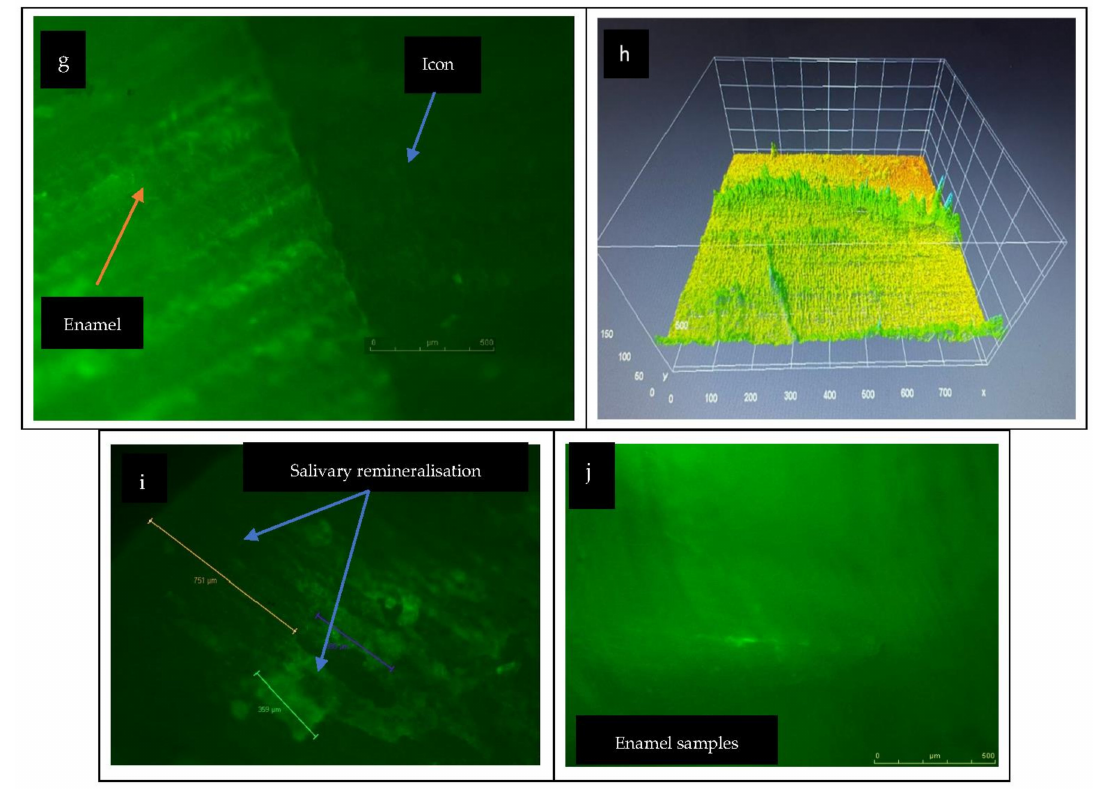
Figure 2. ( a ) CLSM of enamel demineralisation with 3% citric acid. ( b ) CLSM after Fluor Protector infiltration of enamel with 100% penetration (10 × objective in dual fluorescence mode). ( c ) CLSM after Fluor Protector infiltration of enamel with partial penetration; ( d ) the lesions of demineralisation under Fluor Protector infiltration—partial penetration (10 × objective in dual fluorescence mode); ( e ) CLSM after Icon infiltration of enamel; ( f ) Icon infiltration—depth of penetration; ( g ) the difference between Icon treatment and sound enamel; ( h ) 8 h box plot of laser penetration; ( i ) CLSM after pH 8 saliva remineralisation; ( j ) sound enamel samples shown by confocal laser microscopy